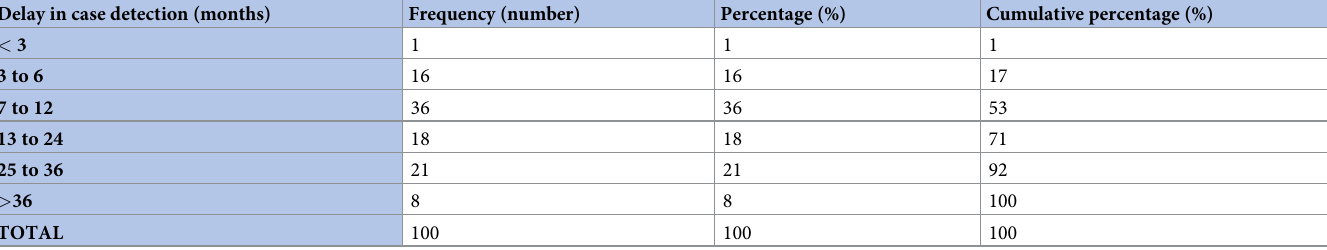
age, rural or urban residence and religion were not associated with delay in case detection in the univariate regression analysis. Table 2. Case detection delay and cumulative percentage among study participants, Eastern Ethiopia, January-February 2019. Delay in case detection